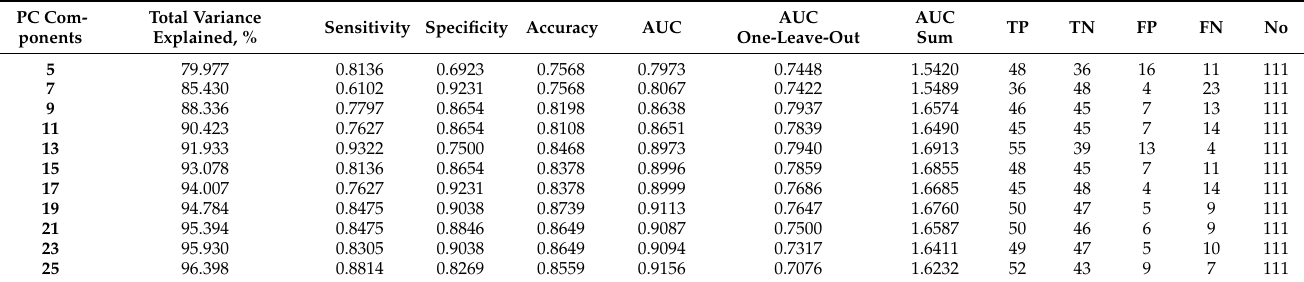
Table 1. Summary table for the set with 100 nm Ag NPs on the silver